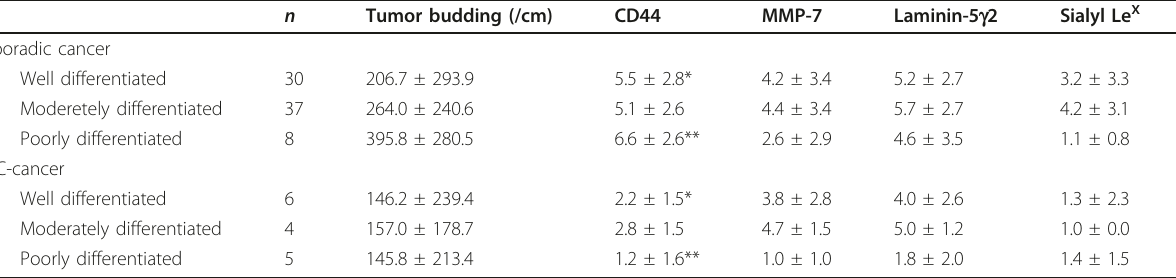
Table 4 Tumor differentiation and budding, and expression of CD44 extracellular domain, MMP-7, laminin-5 g 2, and sialyl Le X in invasive